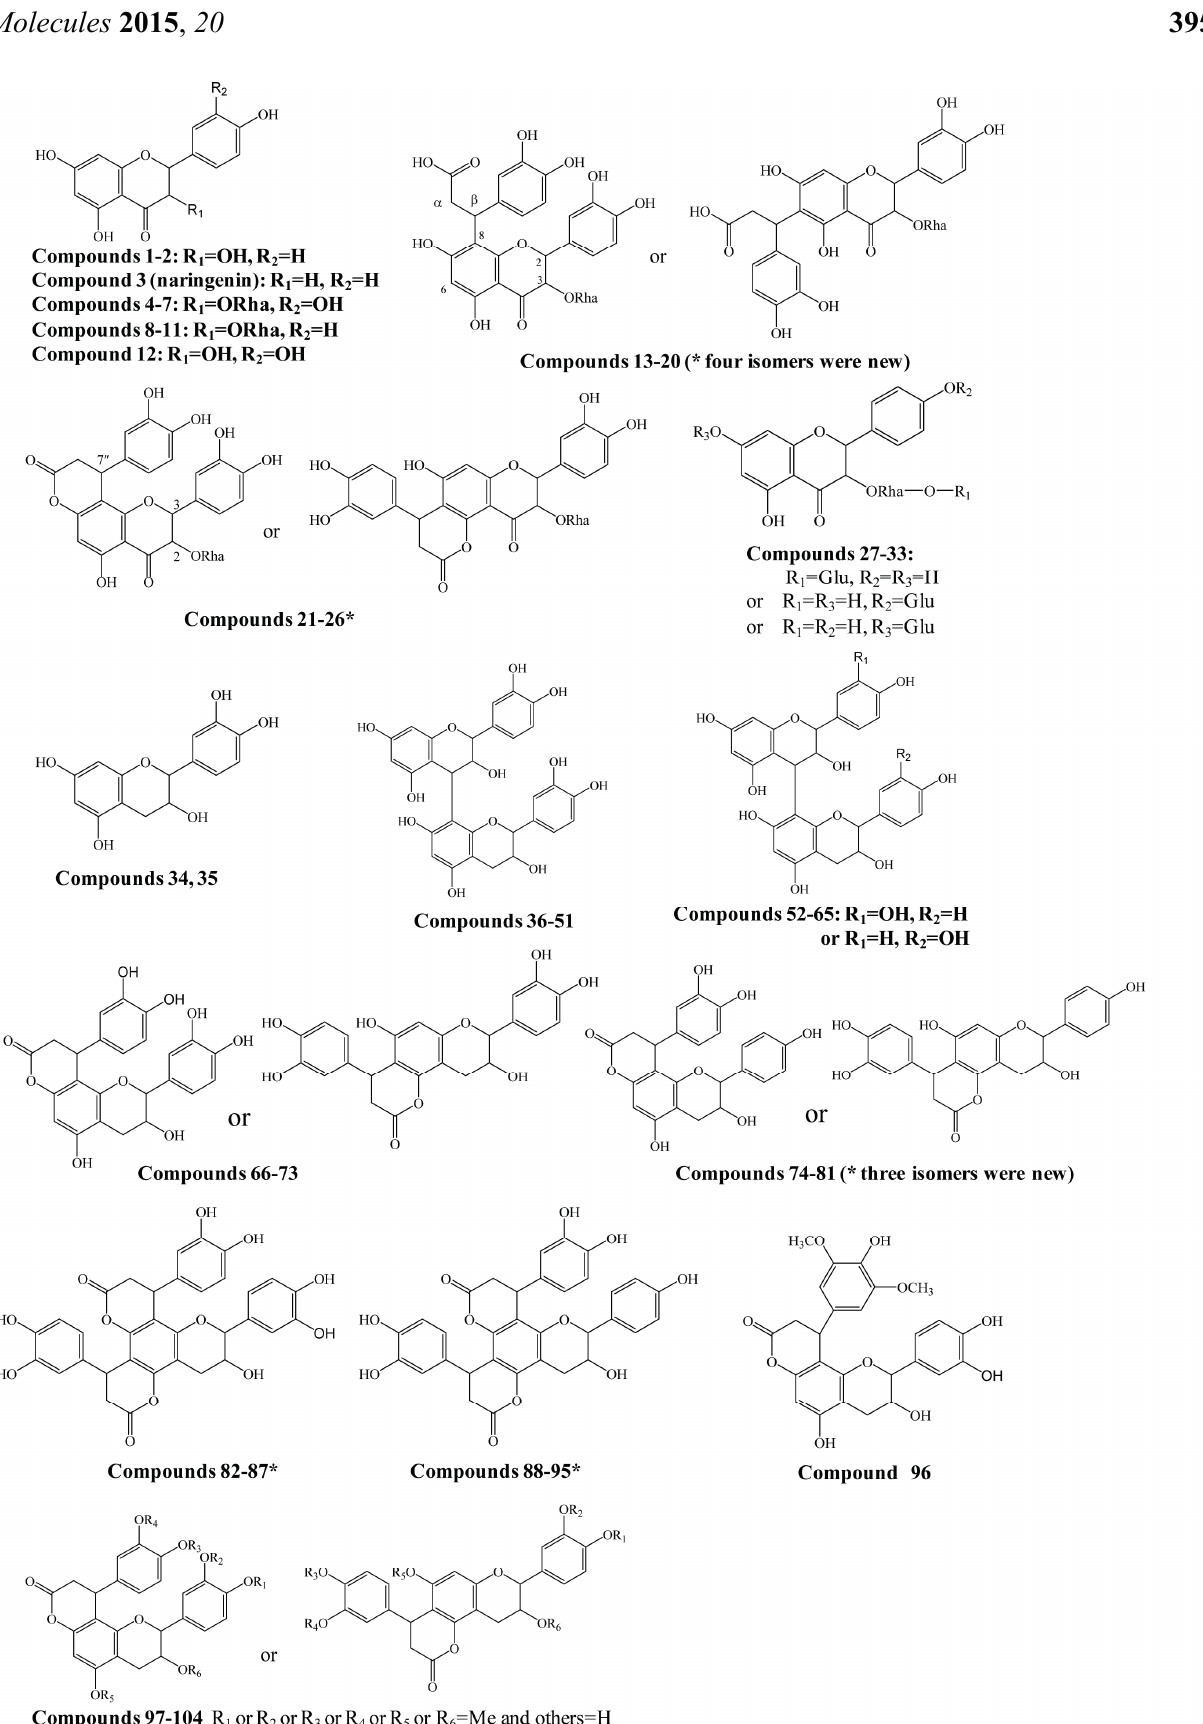
Figure 1. Structures of compounds identified in Smilax glabra . * indicated new